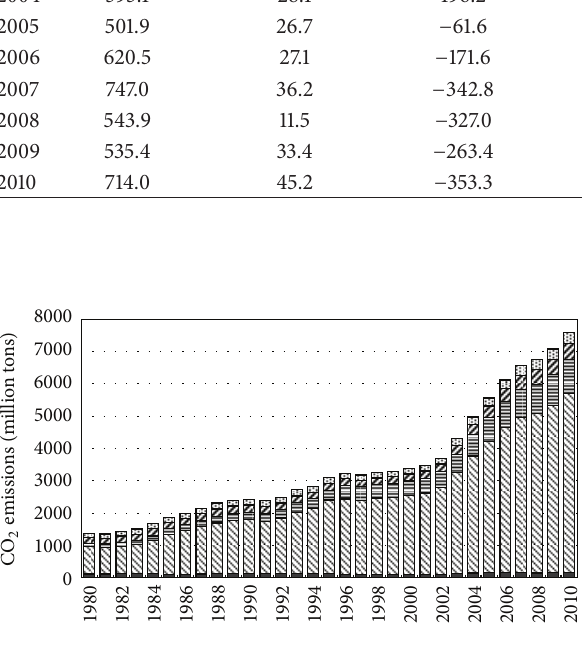
emissions change (1981–2010). 2